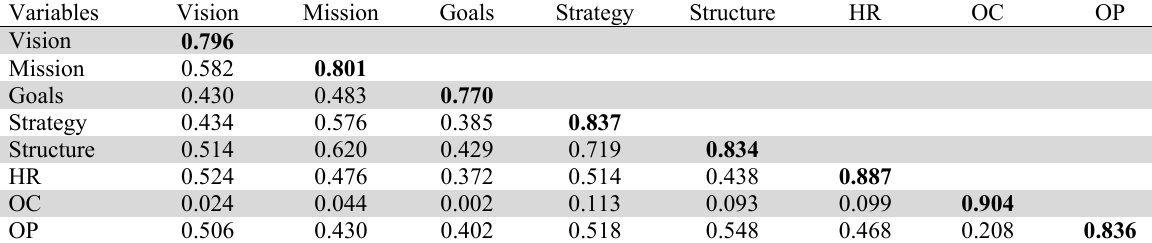
Results of Discriminant Validity for Organizational Performance CFA